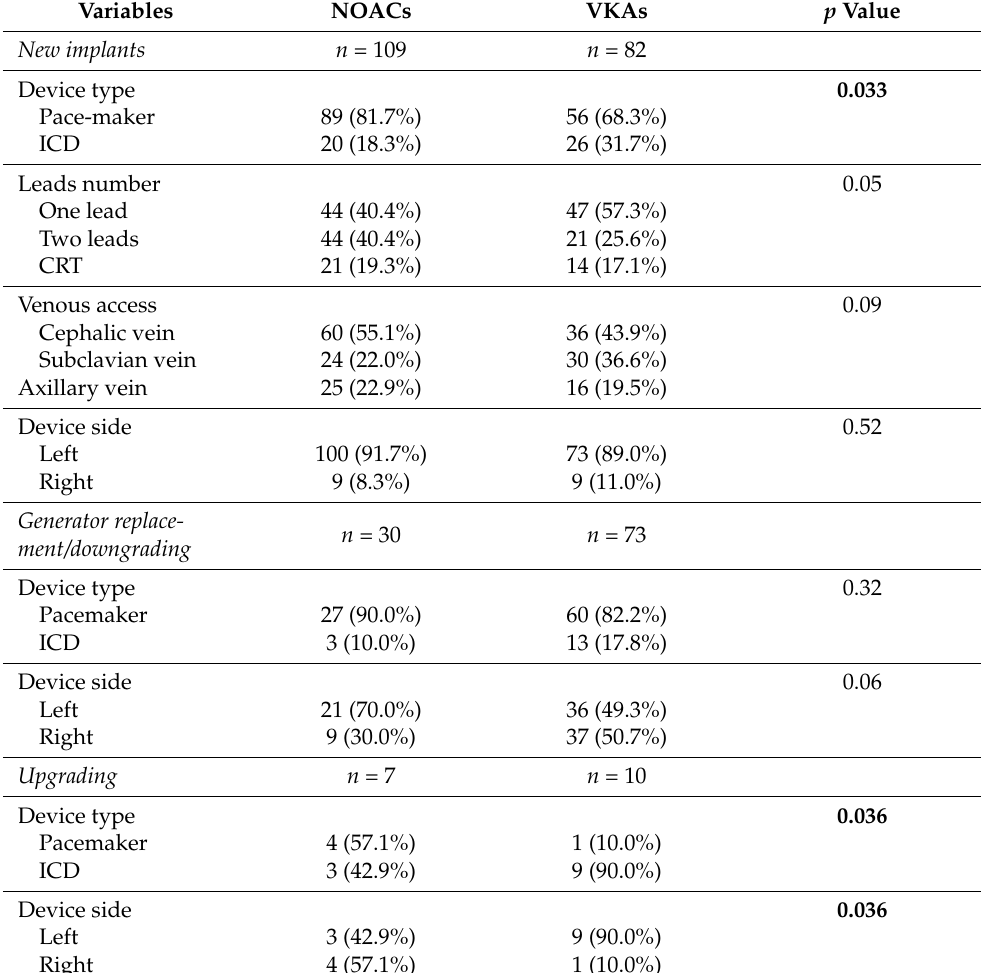
Table 2. Procedural